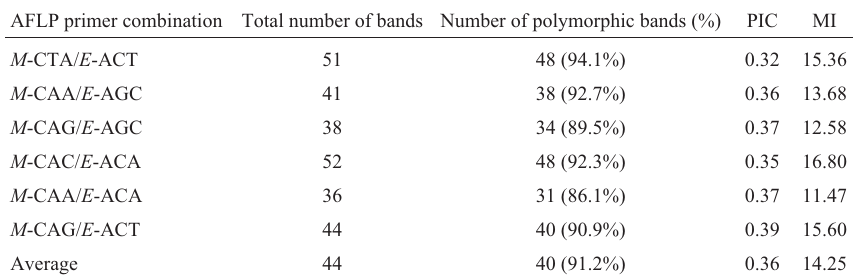
Table 3 - Amplified fragment length polymorphism (AFLP) primer combinations, total number of bands, number and percentage of polymorphic bands, average polymorphic information (PIC) and marker index (MI) per primer combination for 19 wheat genotypes. AFLP primer combination Total number of bands Number of polymorphic bands (%)